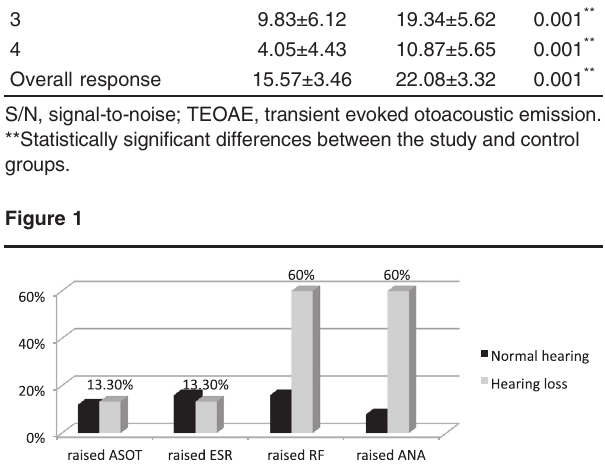
Histogram presented the percentage of patients with raised different autoimmune tests in both the normal hearing and hearing loss groups. ANA, antinuclear antibody; ASOT, antistreptolysin O titer; ESR, erythrocyte sedimentation rate; RF, rheumatoid